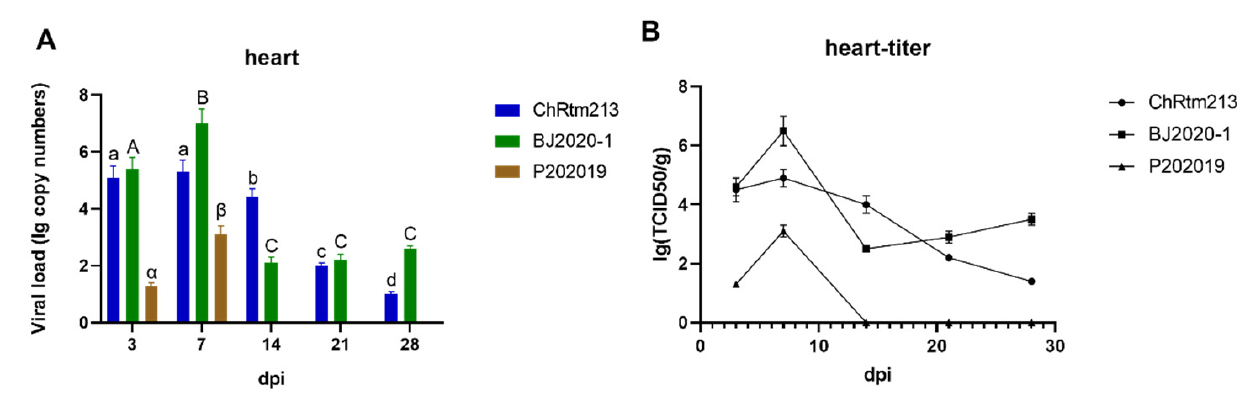
Figure 5. IPNV virus loads in the heart were sampled on 3, 7, 14, 21, and 28 dpi. ( A ) Replication kinetics of IPNV-infected rainbow trout. Samples were obtained in triplicate. Total RNA was extracted and analyzed by qPCR. Error bars represent the SD from triplicate within an experiment. Different letters of the same class indicated the statistical significance, p < 0.05. a, b, c, d indicated that the viral load of IPNV-ChRtm213 was significantly different at different sampling time points, p < 0.05. A, B, C indicated that the viral load of IPNV-BJ2020-1 was significantly different at different sampling time points, p < 0.05. α , β indicated that the viral load of IPNV-P202019 was significantly different at different sampling time points, p < 0.05. ( B ) The detection of viral titers in the heart of IPNV-infected rainbow trout.